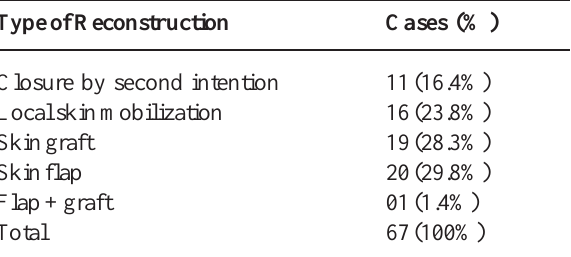
Table 2 – Type of treatment used in the 67 patients af- fected with Fournier’s